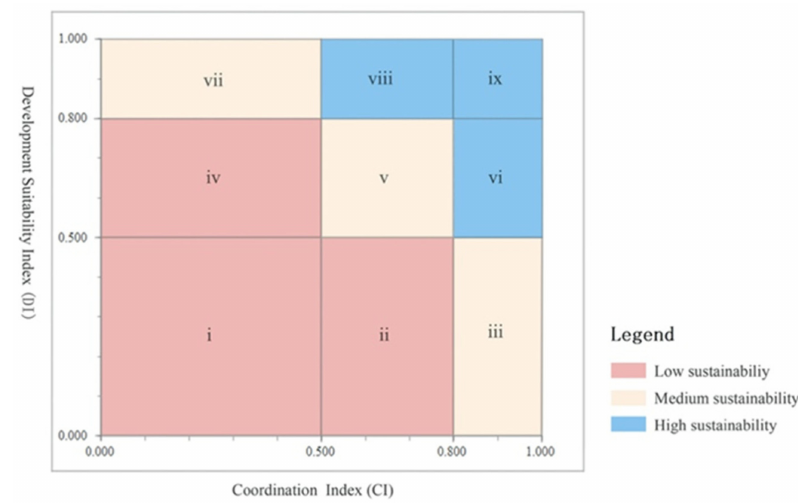
Figure 2. The GE matrix of the DI and CI of FHB